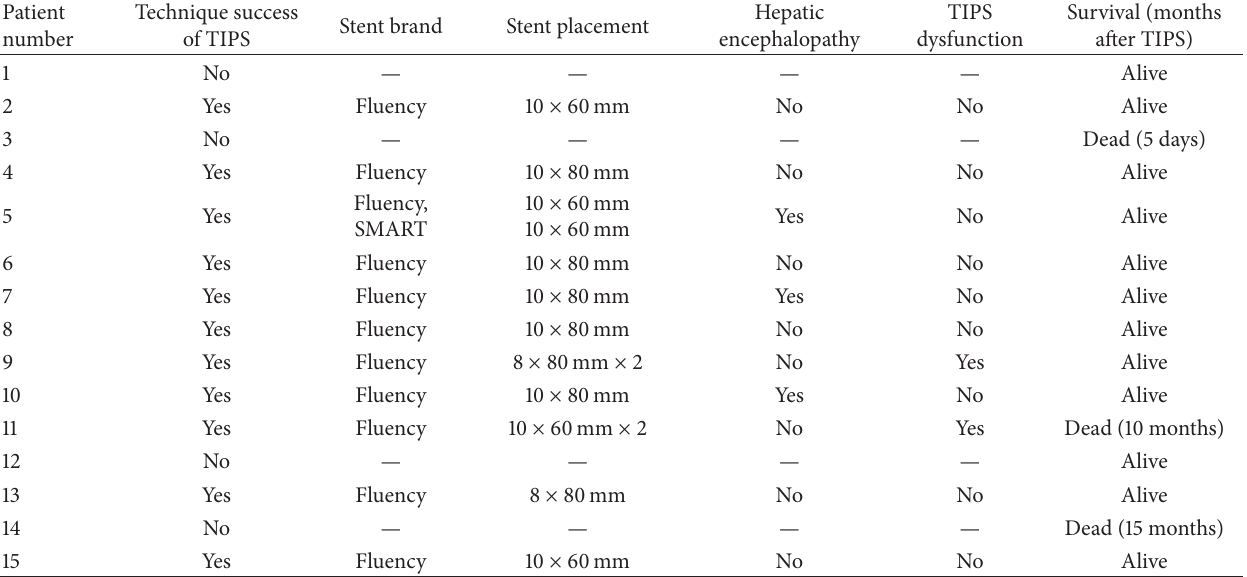
Table 2: Technical details and follow-up